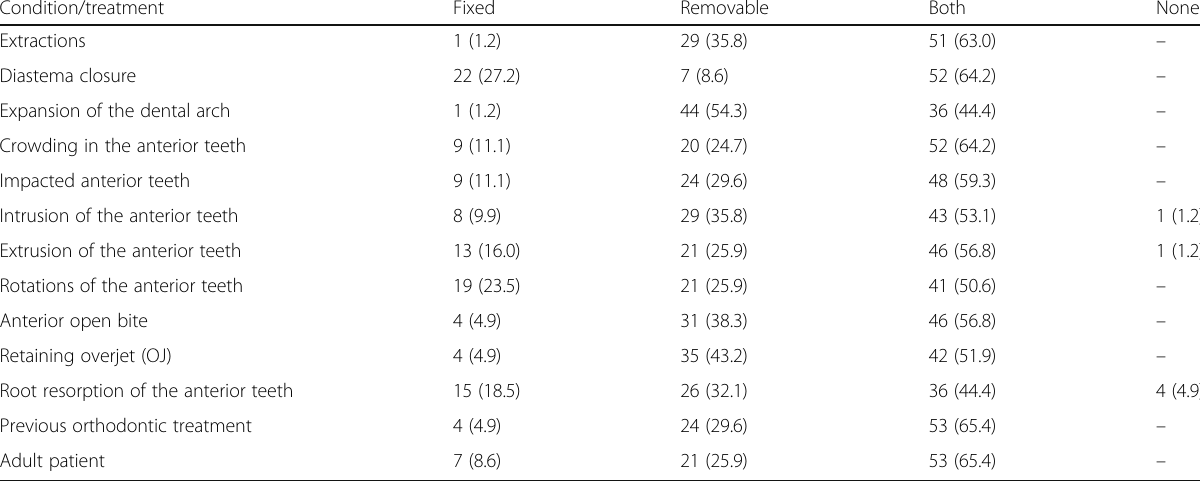
Table 1 Respondents who chose a certain retention in the upper dental arch depending on the condition or treatment